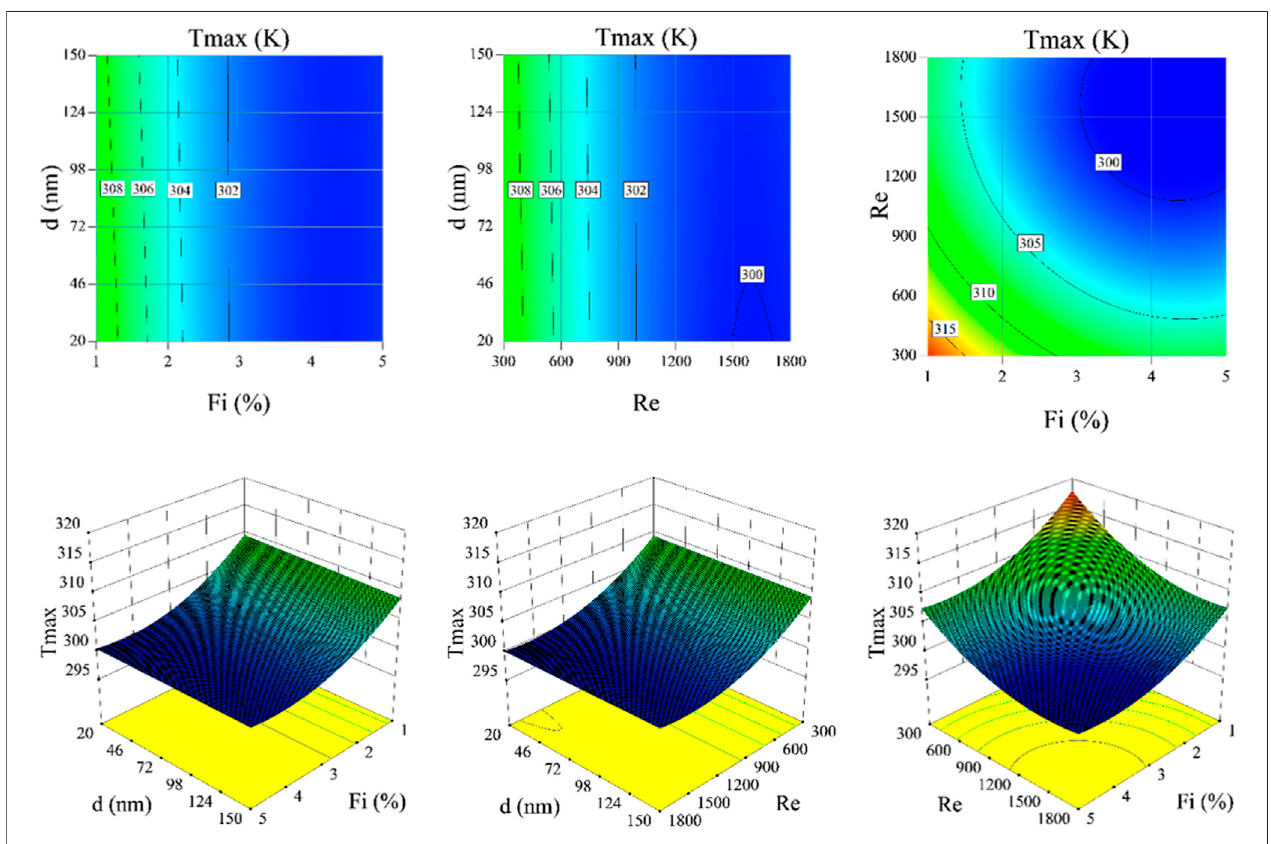
FIGURE 4 | T Max at the bottom of the WMH-S for variations of Re , d , and Fi .